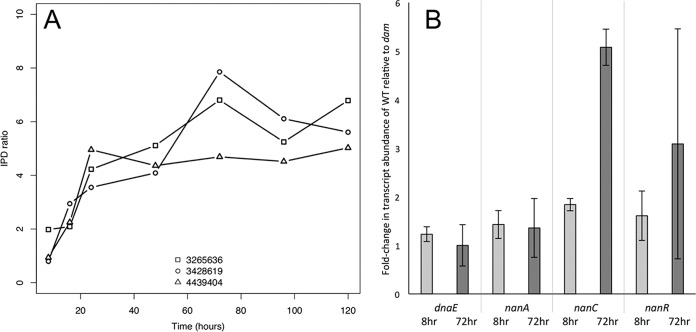
GATC sites where methylation changes over time correspond to a change in gene expression in a dam mutant. (A) IPD ratios of GATC sites with an FDR of <0.05 and involved in sialic acid catabolism across 5 days of incubation. The IPD ratio is the mean IPD of the sample at a specific position divided by the mean IPD of the control (dam mutant) at that same position. Therefore, an IPD ratio of 1 indicates that the means at that position are equal. The positions in the chromosome are shown in the legend (e.g., 3265636). (B) Transcript abundance fold change between WT and dam strains after 8 and 72 h of incubation in LB. Each bar represents an average of three biological replicates, and the error bars show the standard deviations. The dnaE strain is a negative control that is known not to be regulated through Dam methylation (and shows a fold change ratio of ~1). Note that transcription of nanA, whose promoter region does include GATC sites, does not change with the loss of Dam methylation, suggesting that other regulatory mechanisms are at play.